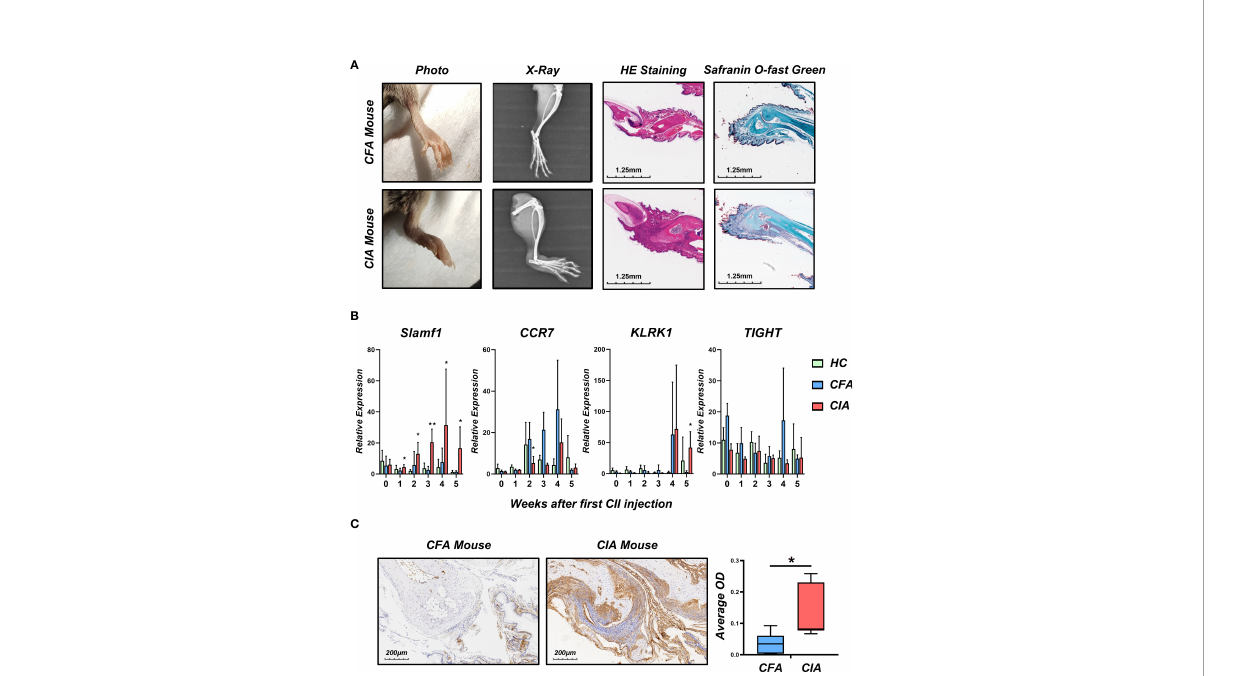
FIGURE 4 Construction collagen-induced arthritis and validation of candidate gene in the model. (A) Photographs, X-ray, H&E and Safranin O-fast green staining images of the hind limbs of CIA and HC 5 weeks after the fi rst CII injection. (B) Realtime-PCR analysis for gene expression of CCR7, KLRK1, TIGIT and SLAMF1 in the PBMC of CIA, CFA control and healthy control (HC) mice every week. (C) Immunohistochemical detection of SLAMF1 expression in joint synovial samples from CIA and CFA mice. Data shown are the mean ± SEM with 6 mice per group and are from one experiment, representative of two performed. *p < 0.05 and **p < 0.01 (Wilcoxon rank-sum test).